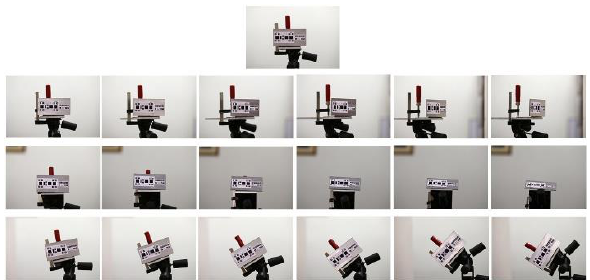
Figure 14. Photos of the marker at different angles of inclination and rotation.